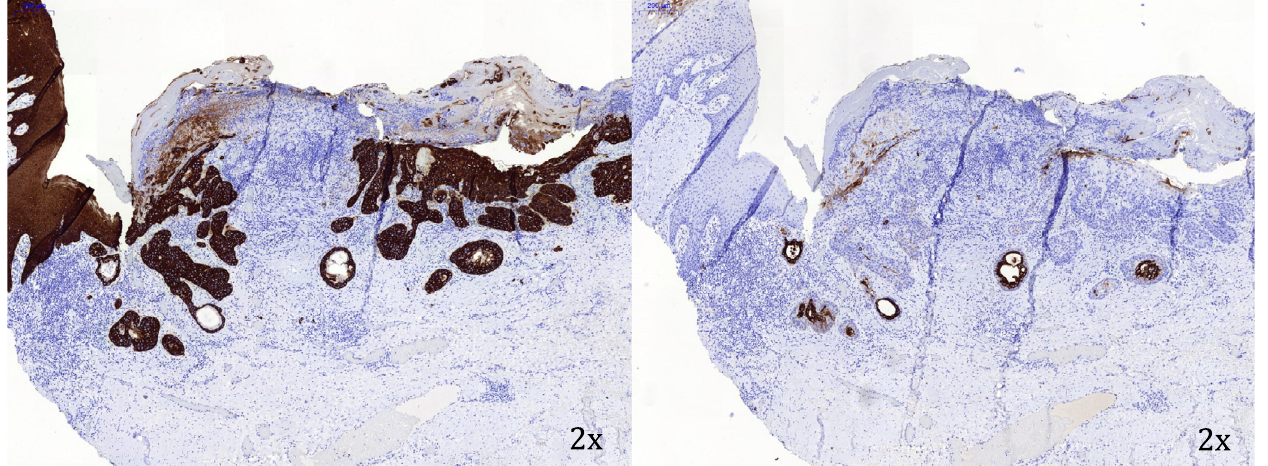
Fig. 4. Surgical specimen – LEFT: CK5/6 positivity for the glandular component and for the epithelial component and RIGHT: CK7 positivity only for the glandular